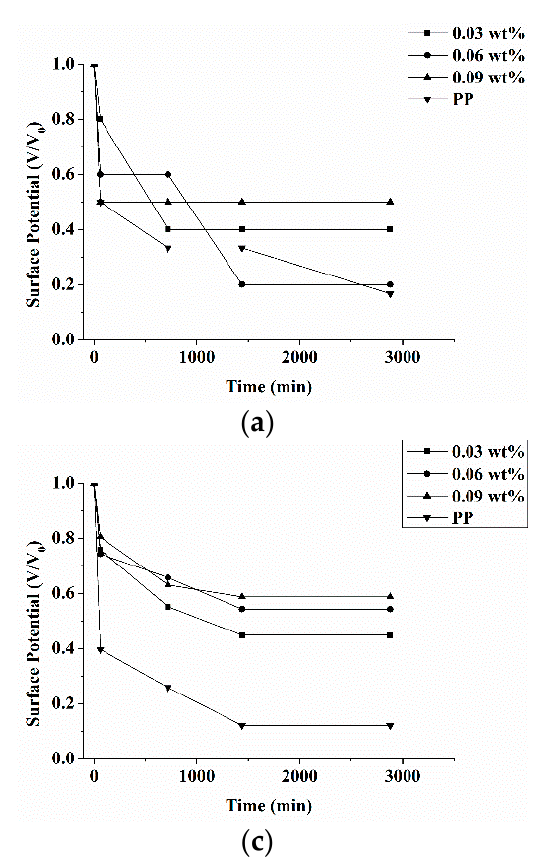
Figure 2. Surface potential of antibacterial electret PP filters as related to triclosan amount (0.03, 0.06, and 0.09 wt%) and electric field intensity at ( a ) 1.5 kV/cm, ( b ) 2.0 kV/cm, and ( c ) 2.5 kV/cm. Table 1. Thermal properties of antibacterial electret PP filters as related to the triclosan amount being 0.03, 0.06, and 0.09